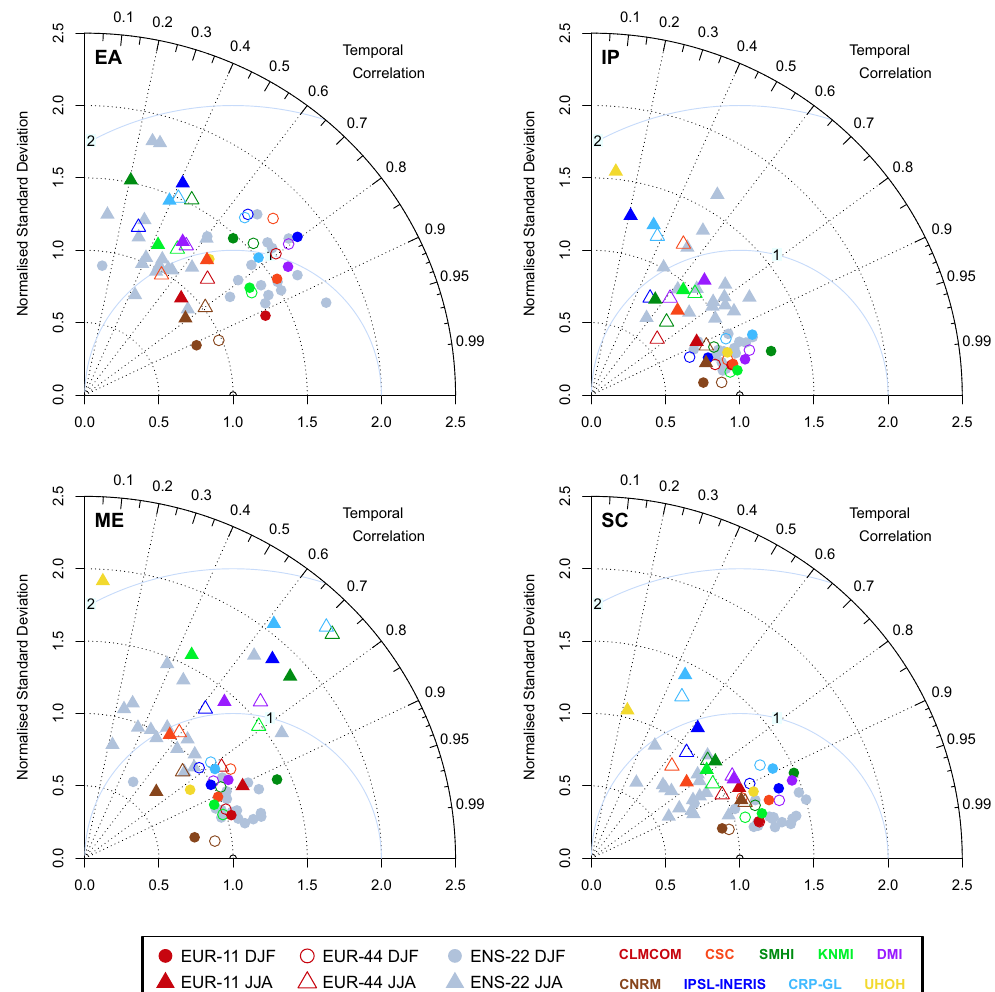
Figure 12. As Fig. 11 but for mean winter (circles) and mean summer (triangles) precipitation. See Fig. B8 for subdomains AL, BI, FR and MD.